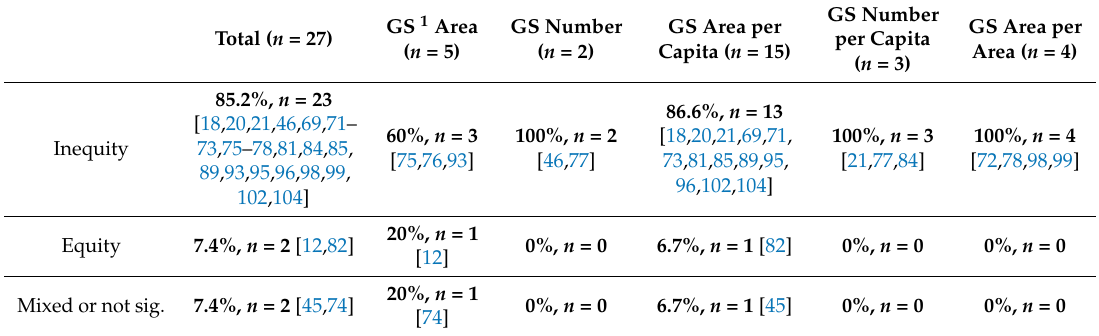
Table 5. Findings for green space quantity, organized by types of quantity measured with article